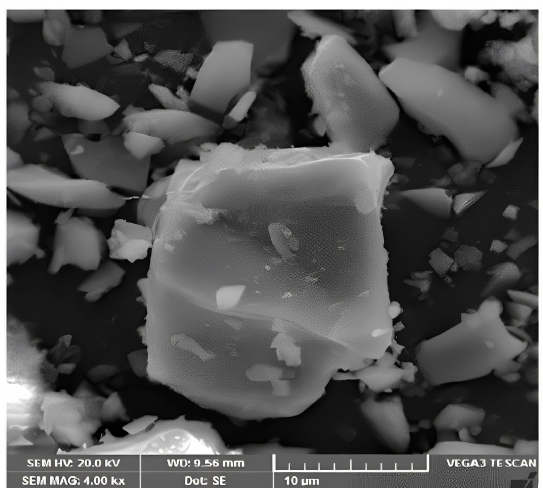
Figure 2. Picture shows GGBS SEM